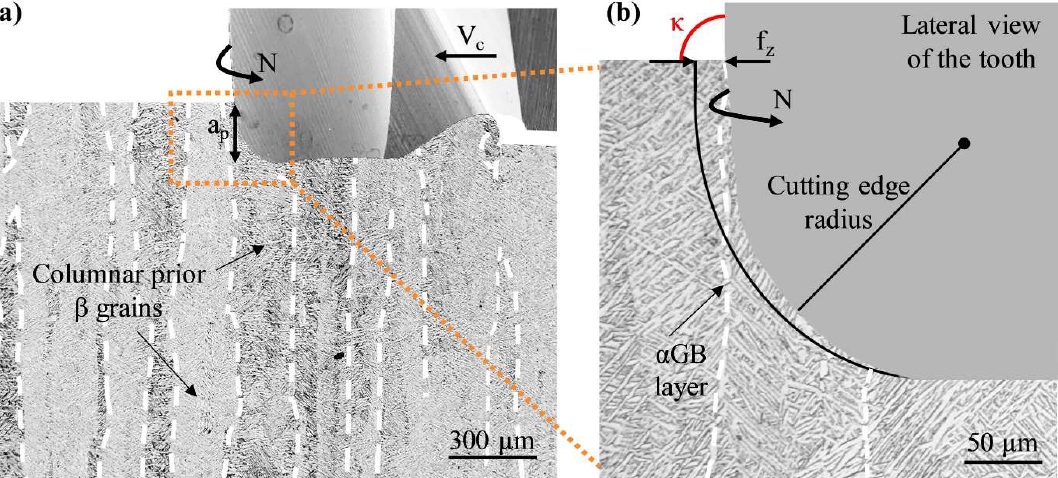
Figure 20. ( a ) Tool engagement with respect to the prior β grain orientations for the 0° sample, and ( b ) zoomed picture showing the orientation angle of the αGB layers relative to the cu(cid:308)ing tool